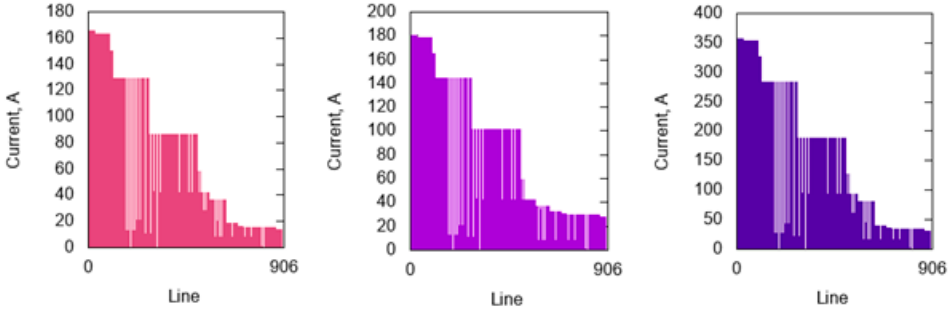
Figure 6. Snapshot of Current levels at peak time. Normal circumstances, under Scenario 1 attack, under Scenario 2 attack respectively.